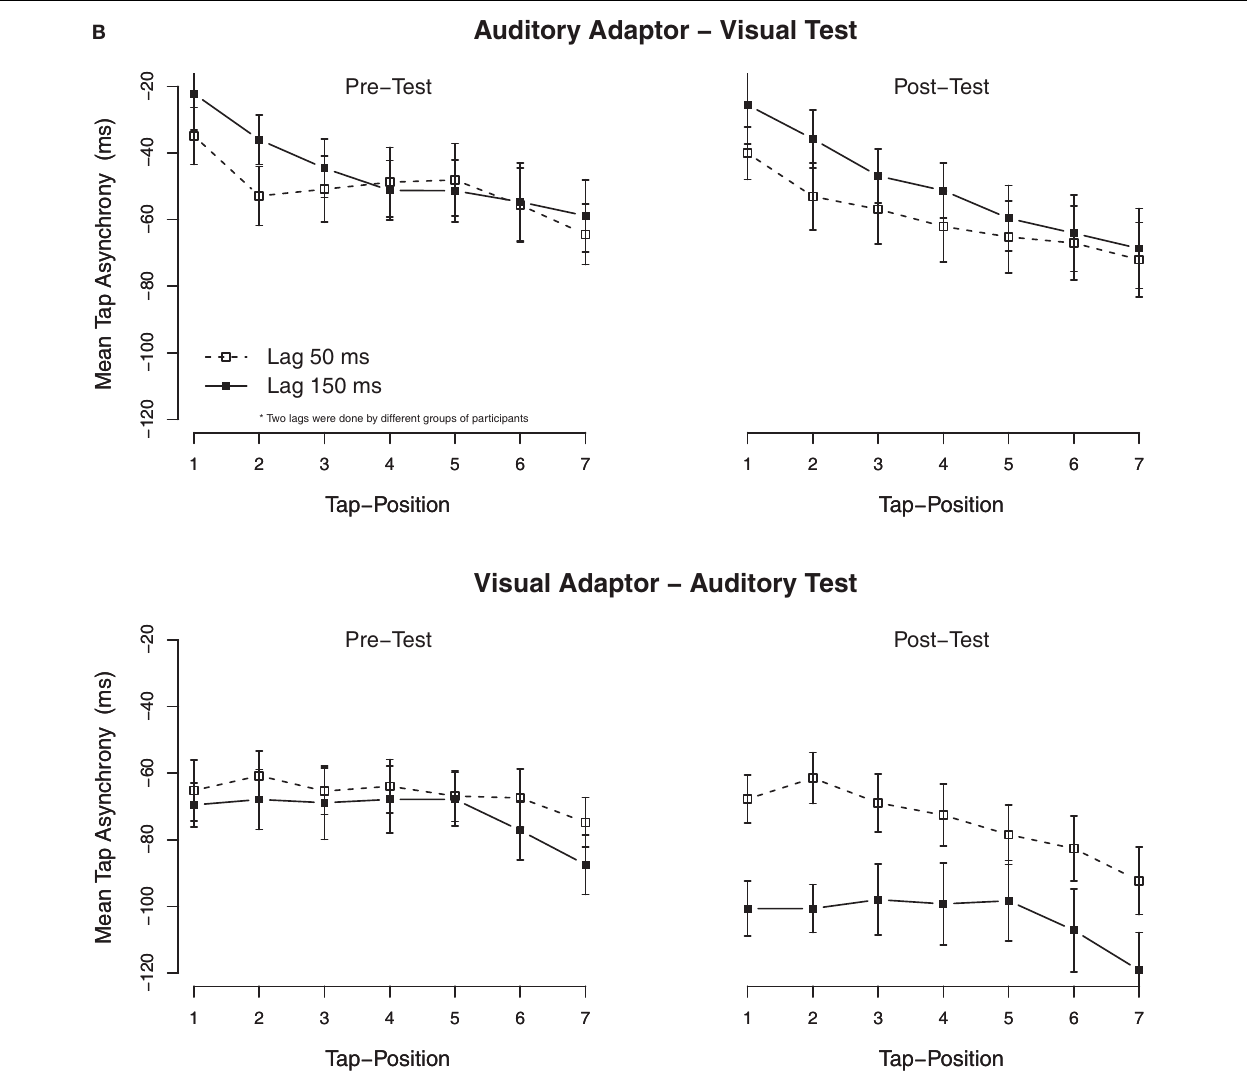
FIGURE 3 | Mean tap asynchronies in Experiment 2. (A) Mean tap asynchronies per trial block. One block contained three consecutive trials (the last block contained only two trials). (B) Mean tap asynchronies per tap in one trial. One trial contained seven taps.